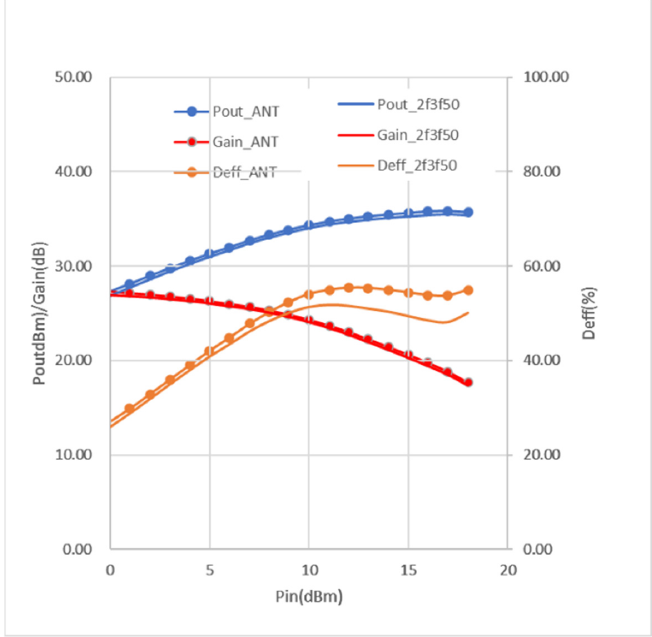
Figure 17. Effect of the harmonic reflection function of the antenna on the output power, gain, and drain efficiency of the amplifier. These results are the measured values when an impedance tuner is connected to the amplifier as a load impedance. The trace “_ANT” shows the measured value when the antenna impedance for the fundamental, second-harmonic, and third-harmonic frequencies shown in Figure 3 are set to the impedance tuner. The trace “_2f3f50” shows the measured value when the antenna impedance for the fundamental frequency shown in Figure 3 is set to the tuner, but an impedance of 50 ohm is set for the second- and the third-harmonic